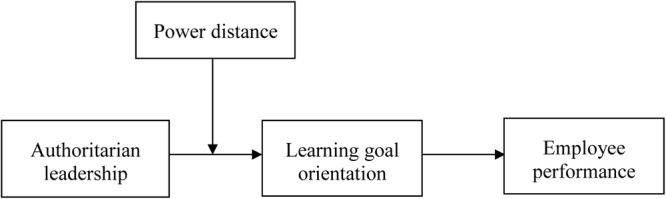
Theoretical model.